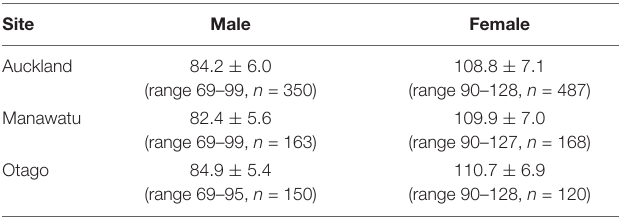
TABLE 1 | Summary of bar-tailed godwit bill lengths (mm, mean ± SD, range and n ) by sex and